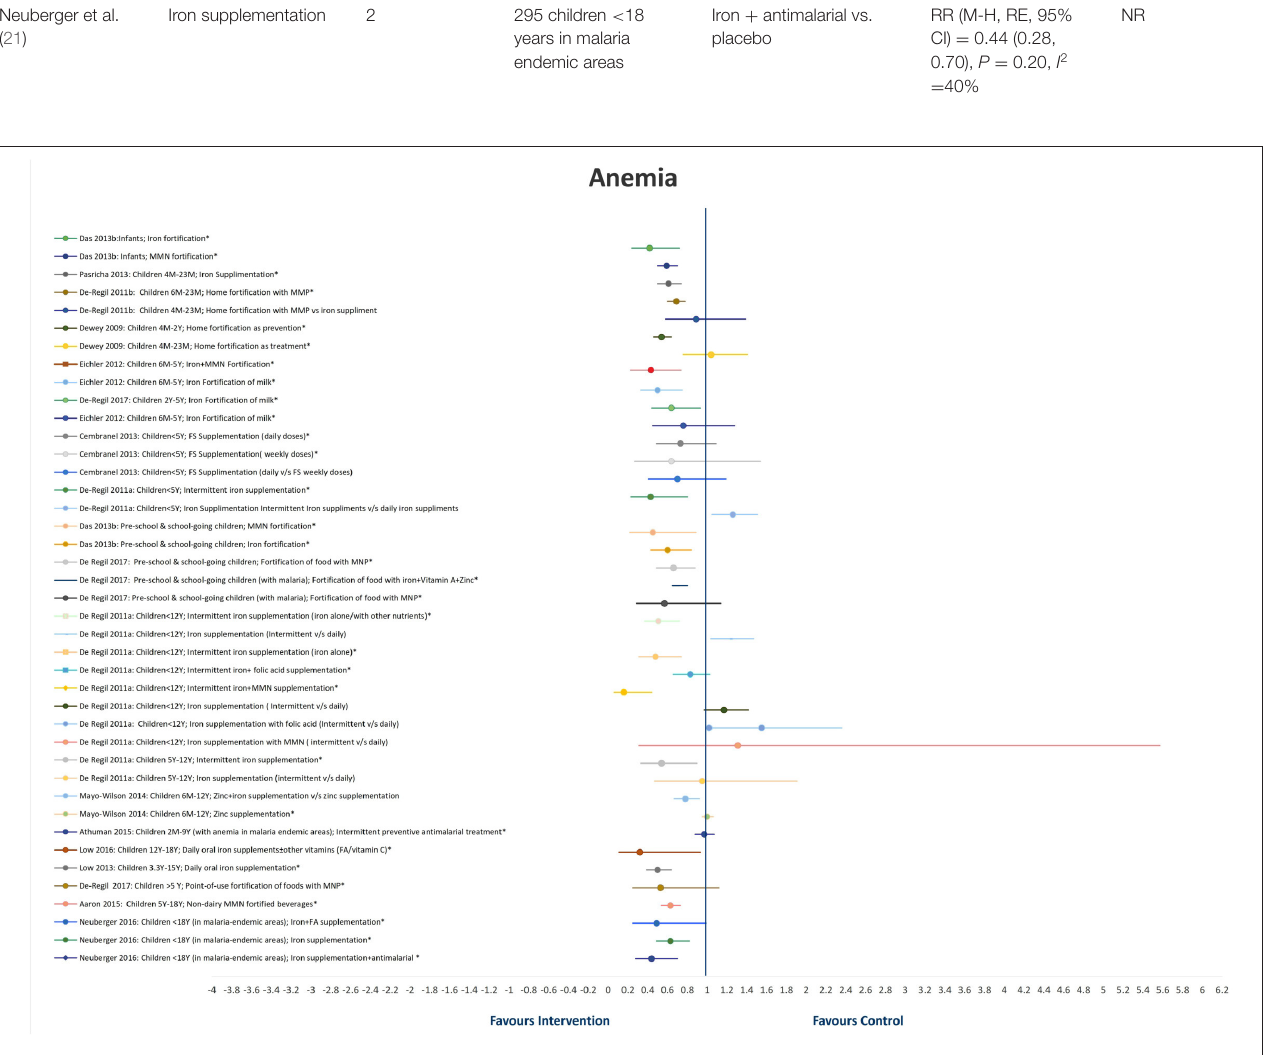
FIGURE 2 | Findings of systematic reviews on